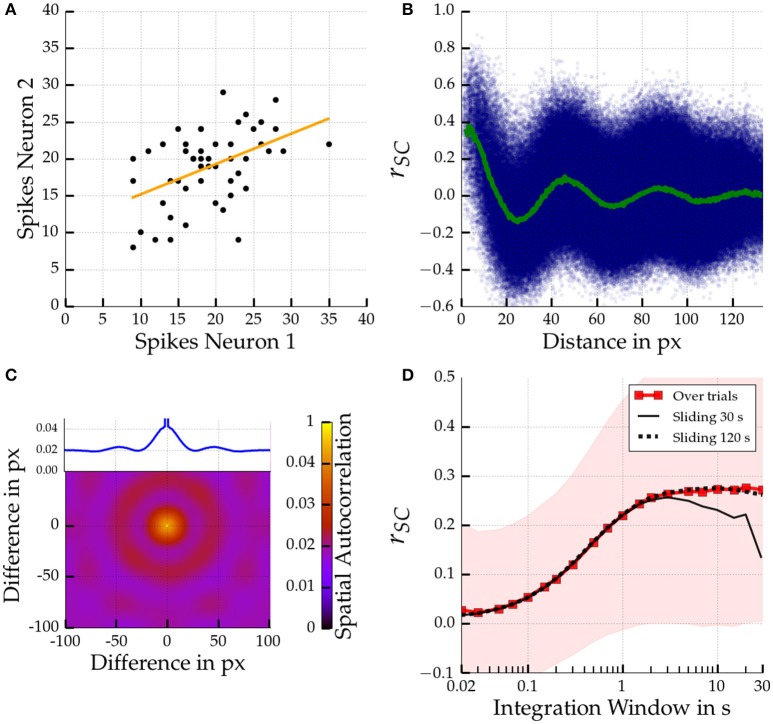
Spatial scales of noise correlations for a large 200 px × 200 px Mexican hat network. Parameters are σE = 10 px < σI = 15 px, ḡEE = 0.4 nS, ḡIE = 0.6 nS. Top left (A): Distribution of spike counts given a 10 s integration time window for two pairs of two directly neighboring cells. The corresponding correlation coefficient is rSC = 0.46 (p < 0.001). The regression line is given in orange. Top right (B): Noise correlations for pairs of cells according to distance computed across 50 stimulus presentations using a 1 s integration window. The correlation coefficient of each individual cell pair is indicated by a small blue dot. The average coefficient of correlation as a function of distance is shown in green. A decaying oscillation of average correlations can be observed. Bottom left (C): Spatial Autocorrelation of the spike counts in the Mexican hat network. Inset shows autocorrelation along the horizontal axis. Bottom right (D): Temporal scales in terms of the average spike count correlation coefficient as a function of integration window size averaged across all cells at most 13.3 px (which corresponds to 0.2 mm in the scaling to cat cortex) apart. The thin black lines show the average noise correlation if estimated from sliding windows over a single experimental run of 30 s and 120 s (dotted). The envelope shows the standard deviation of noise correlation among all cell pairs.